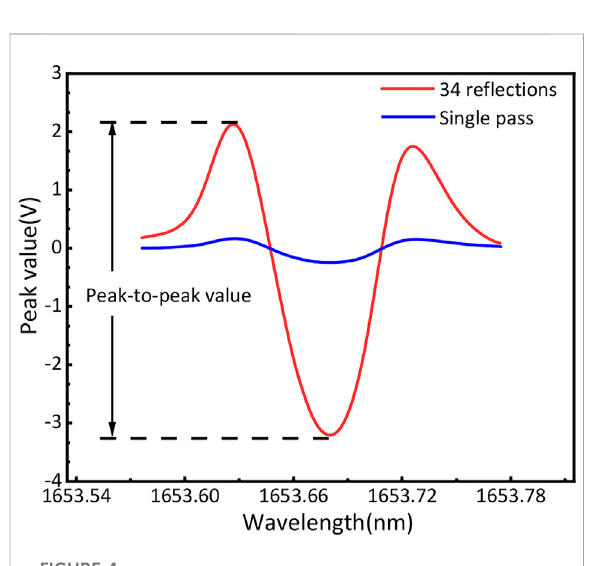
FIGURE 4 2 f signal of the 34 re fl ected PA system (blue line) and single- pass conventional standard PA system (red line),